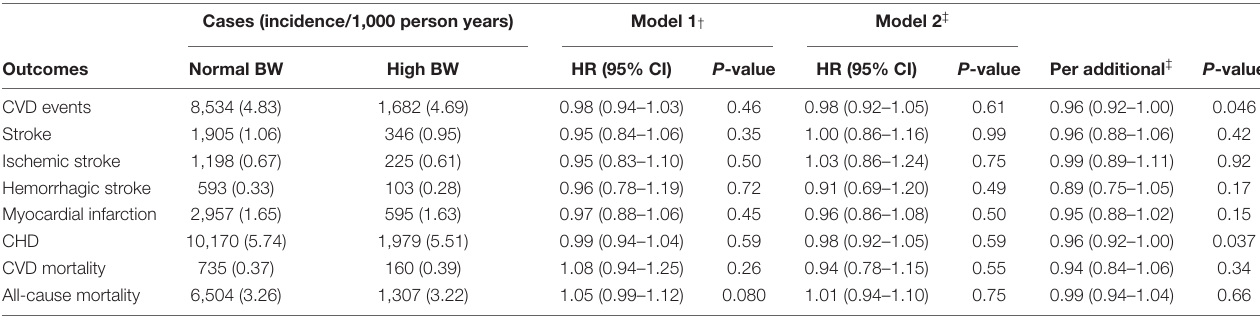
TABLE 3 | Association between high birth weight and risk of cardiovascular